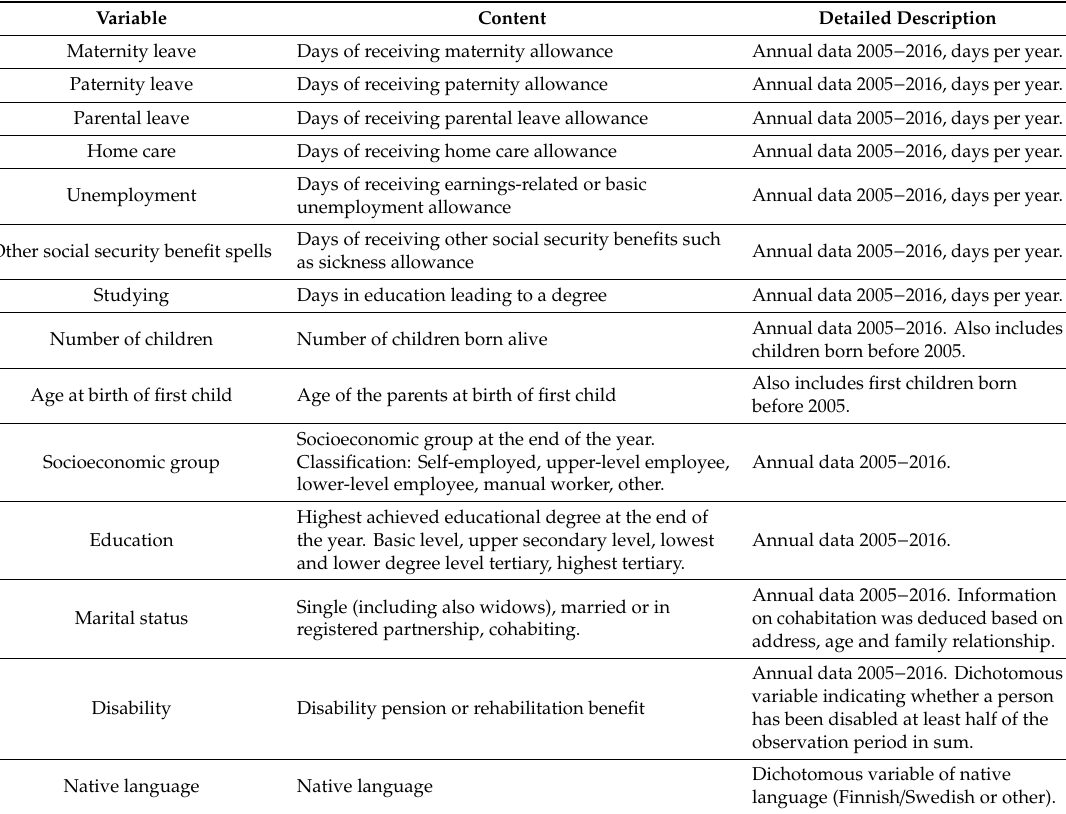
Table A1. Variable